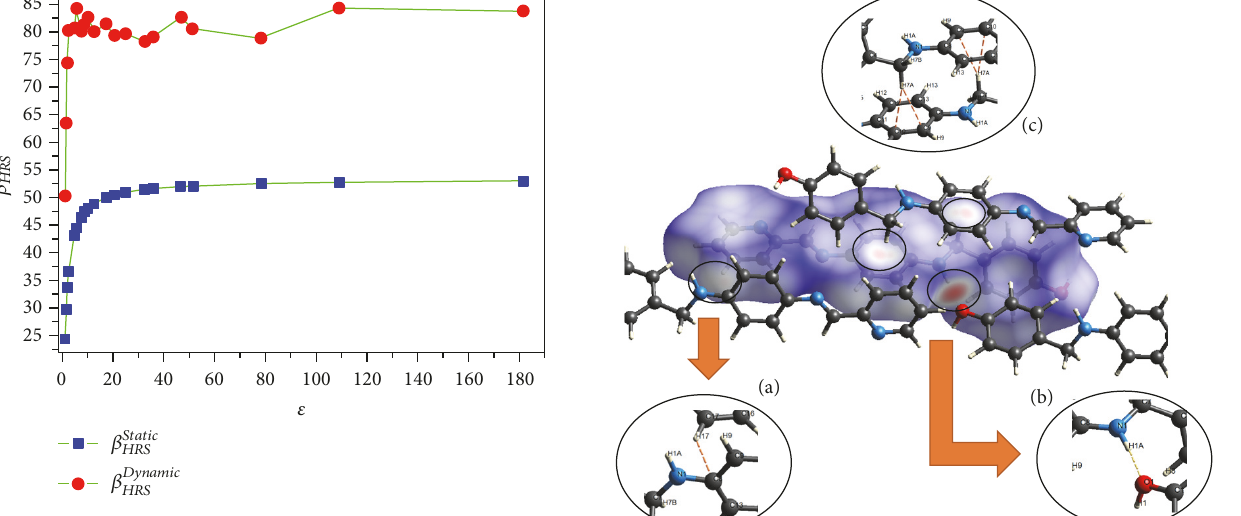
Figure 7: Static and dynamic (1064nm) HRS first hyperpolarizabil- ity as function of the 𝜀 -value.